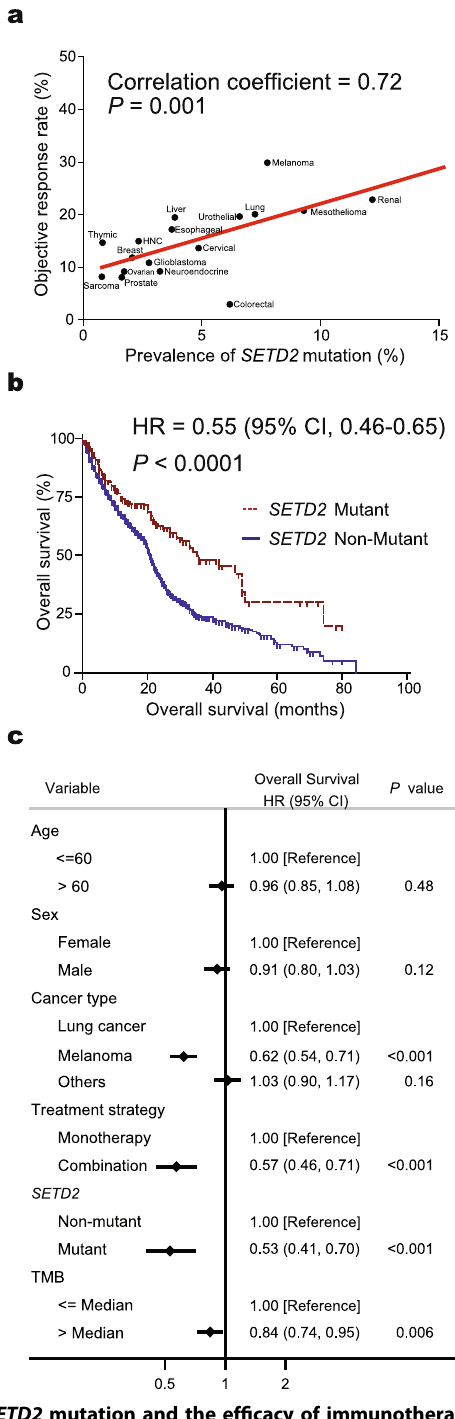
Fig. 3 SETD2 mutation and the ef fi cacy of immunotherapy. a The correlation between the frequencies of SETD2 mutation and objective response rates across multiple tumors. Red line, fi tted curve; HNC, head and neck cancer. b Kaplan – Meier survival analysis strati fi ed by SETD2 mutation status in 2734 cancer patients treated with immune checkpoint inhibitors. CI, con fi dence interval; HR, hazard ratio. c Multivariate analysis of the association between SETD2 mutation and overall